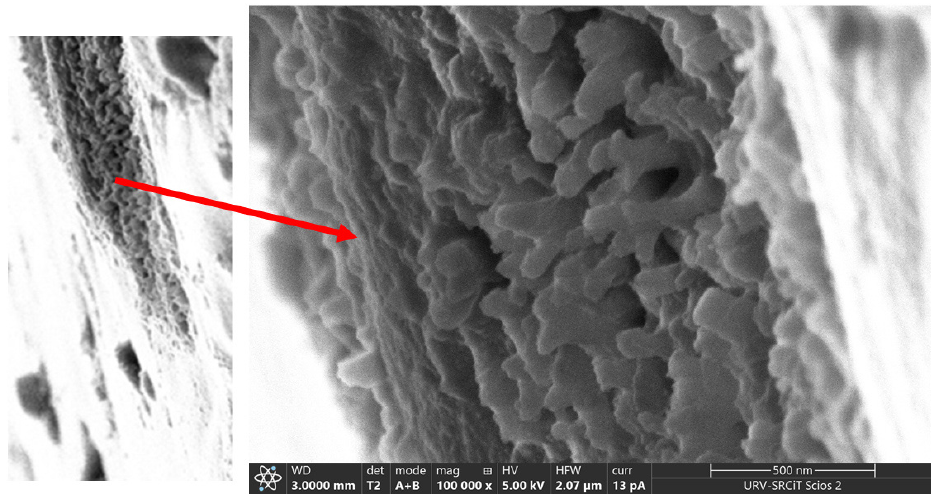
Figure 4. FESEM image of the scratched surface of CP40 oriented membrane. Left: membrane surface with scratched portion; Right: zoom of the scratched area.